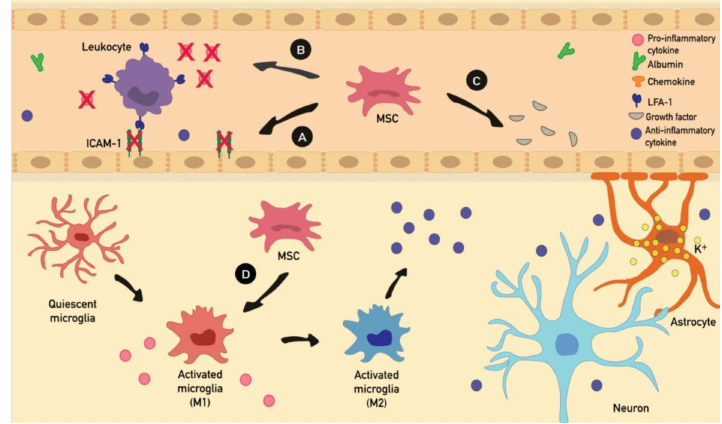
Figure 3. The putative e ff ects of MSC therapy on the inflammatory cascade of events during seizures. ( A ) MSCs downregulate adhesion molecule (e.g., ICAM-1) expression. ( B ) MSCs inhibit leukocytes by blocking their pro-inflammatory factor expression, resulting in decreasing levels of proinflammatory cytokine and leukocyte cell recruitment at the site of damage. ( C ) MSCs release various factors (e.g., KGF, EGF, VEGF and PDGF), involved in maintaining endothelial integrity and preventing interactions between leukocytes and endothelial cells. ( D ) In addition, MSCs promote the switching of microglia from a pro-inflammatory (type 1) to an anti-inflammatory (type 2) phenotype, thus increasing the level of anti-inflammatory cytokines (IL-4 and IL-10). Anti-inflammatory cytokines reduce inflammation by suppressing microglia and T cell activation, pro-inflammatory cytokine production, and leukocyte